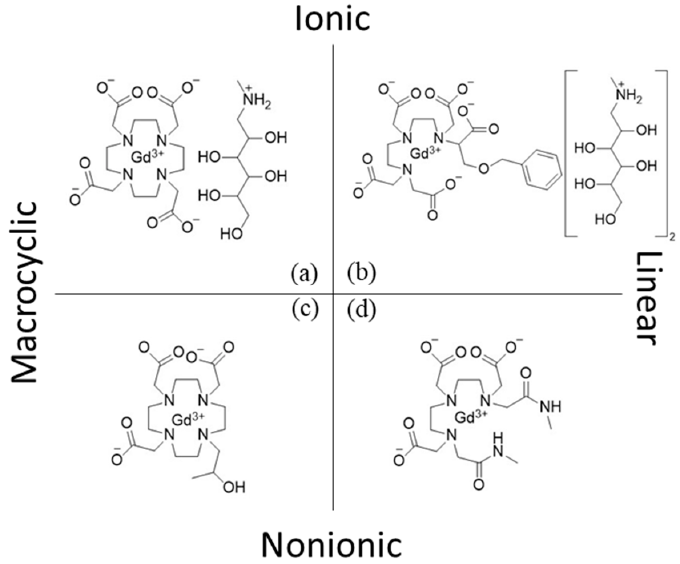
Figure 1. Structure and type of commercially approved gadolinium contrast agents used in MRI. ( a ) Gd-DOTA (Dotarem), ( b ) Gd-BOPTA (MultiHance), ( c ) Gd-HP-DO3A (ProHance), and ( d ) Gd-DTPA-BMA